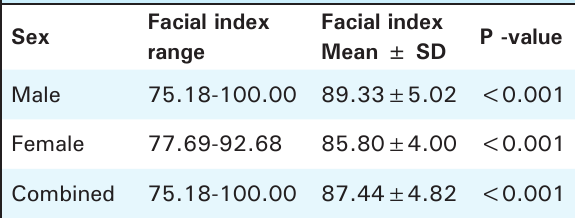
Figure 1. Distribution of face types among the studied